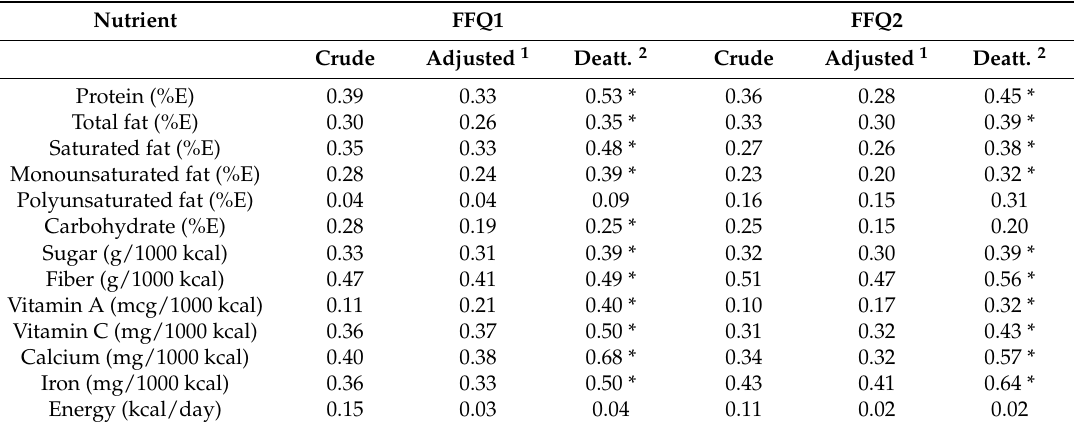
Table 3. Pearson correlations between FFQ1 and FFQ2 with 24-h dietary recalls, n = 161. Nutrient FFQ1